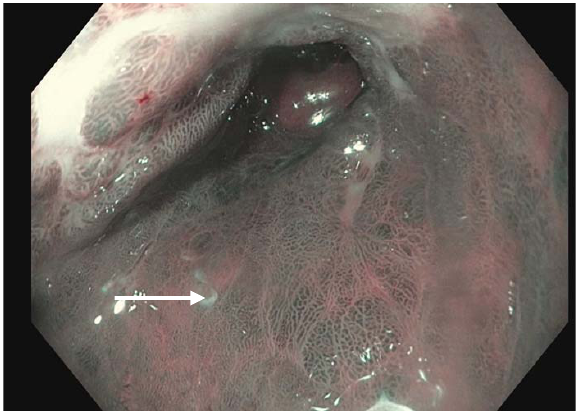
Figure 1. Narrow band imaging applied to a segment of Barrett’s esophagus (white